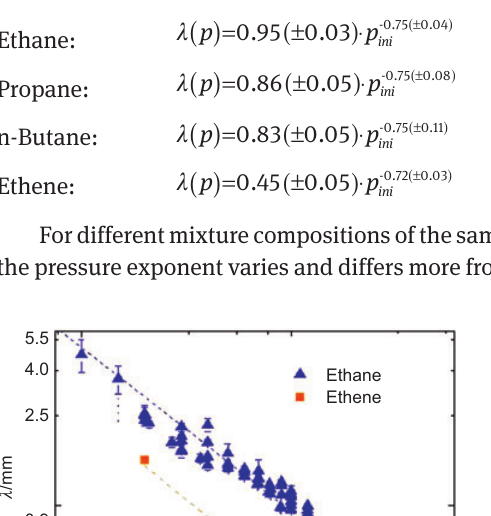
( Figure 9 ) as well as for non-stoichiometric (equivalence ratio ≠ 1) ( Figure 10 ) mixtures.